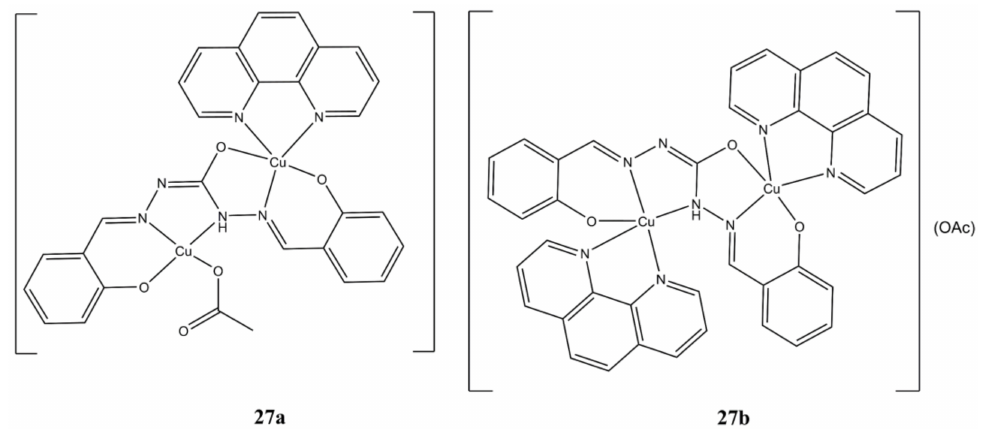
Figure 27. Structure of complexes [Cu(phen)(SCH)Cu(OAc)] ( a ) and [Cu 2 (SCH)(phen) 2 ](OAc) ( b ).